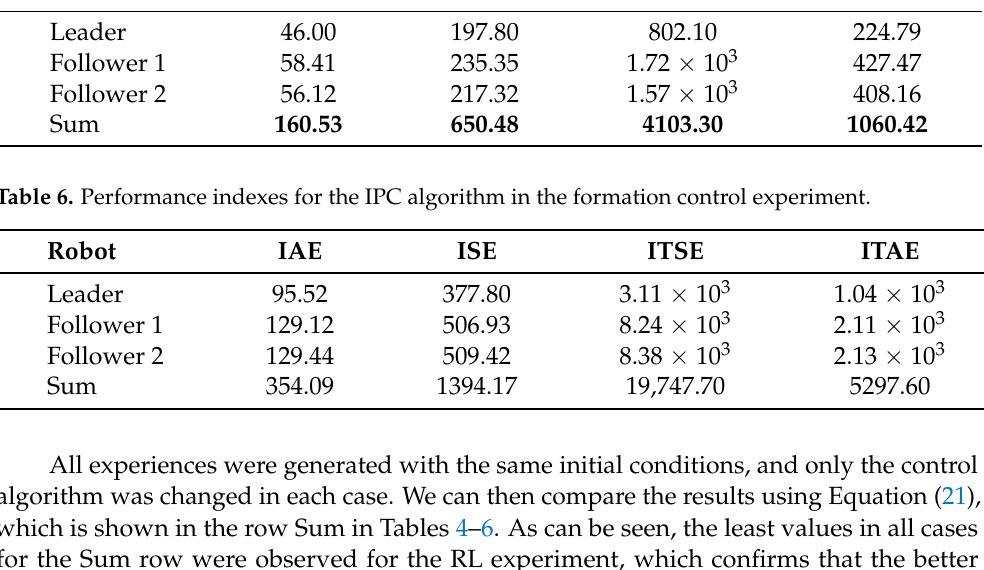
Table 5. Performance indexes for the RL4M algorithm in the formation control experiment. Robot